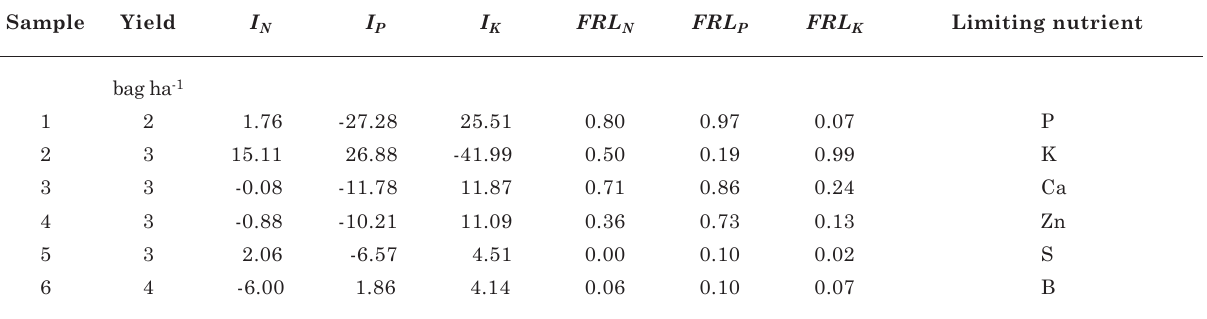
table 6. Comparison between the interpretation of leaf contents of n, p and k using dris and FRL